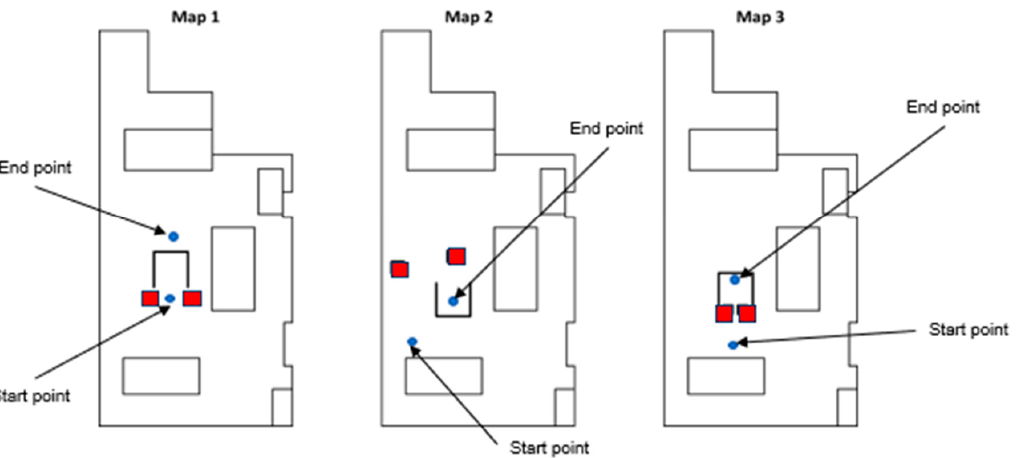
Figure 5. These three maps are used in the validation of the experimental work; the static obstacles are marked in red.